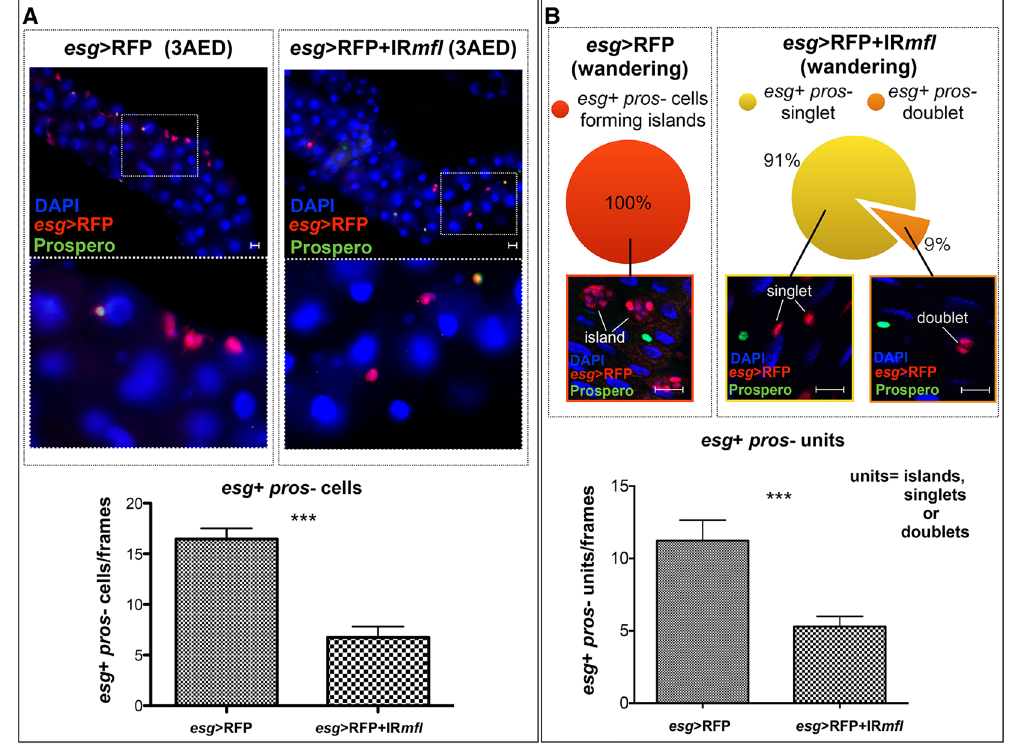
Figure 5. Developmental time-course analysis of stem cell progenitors in dyskerin-depleted midguts. Epifluorescence images of control ( esg -Gal4/ + ;UAS-RFP/ + ) and silenced midguts ( esg -Gal4/UAS-IR mfl ; UAS-RFP/ + ) at 3 days AED ( A ) or at later wandering stage ( B ). DAPI is in blue; esg -expression domain in red; staining with anti-Prospero in green. Scale bars: 20 µ m. esg + pros - cells were counted for frame (at 40X magnification) and the percentage of the different types of organization monitored at the two developmental times; data were subjected to statistical analysis (Mann-Whitney test) and showed by histograms below. ( A ) At 3 days AED, the number of esg + pros - cells counted shows a 60% reduction in silenced respect to control midguts. ( B ) At the wandering stage, esg + pros - cells are all clustered into imaginal islands (100%) in control midguts, while in silenced midguts 91% of these cells appear as singlets, and 9% as